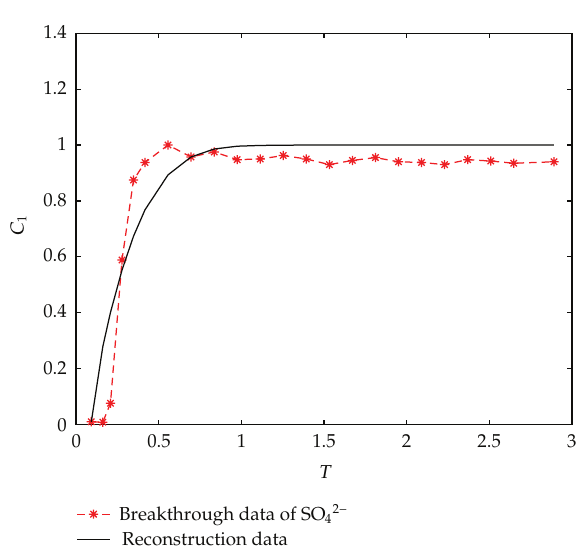
Figure 4: The breakthrough data and reconstruction data for SO 42 −